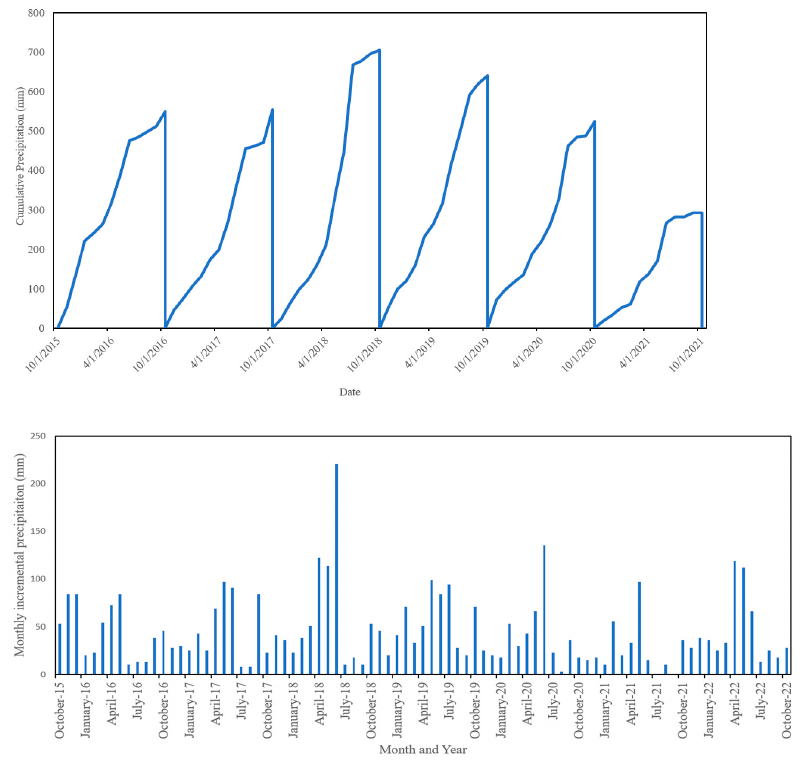
Figure 7. Basin Creek SNOWTEL station precipitation data. Top–Water year cumulative precipitation data (cumulative for water year beginning 1 October and ending 30 September). Bottom–Monthly incremental precipitation values.